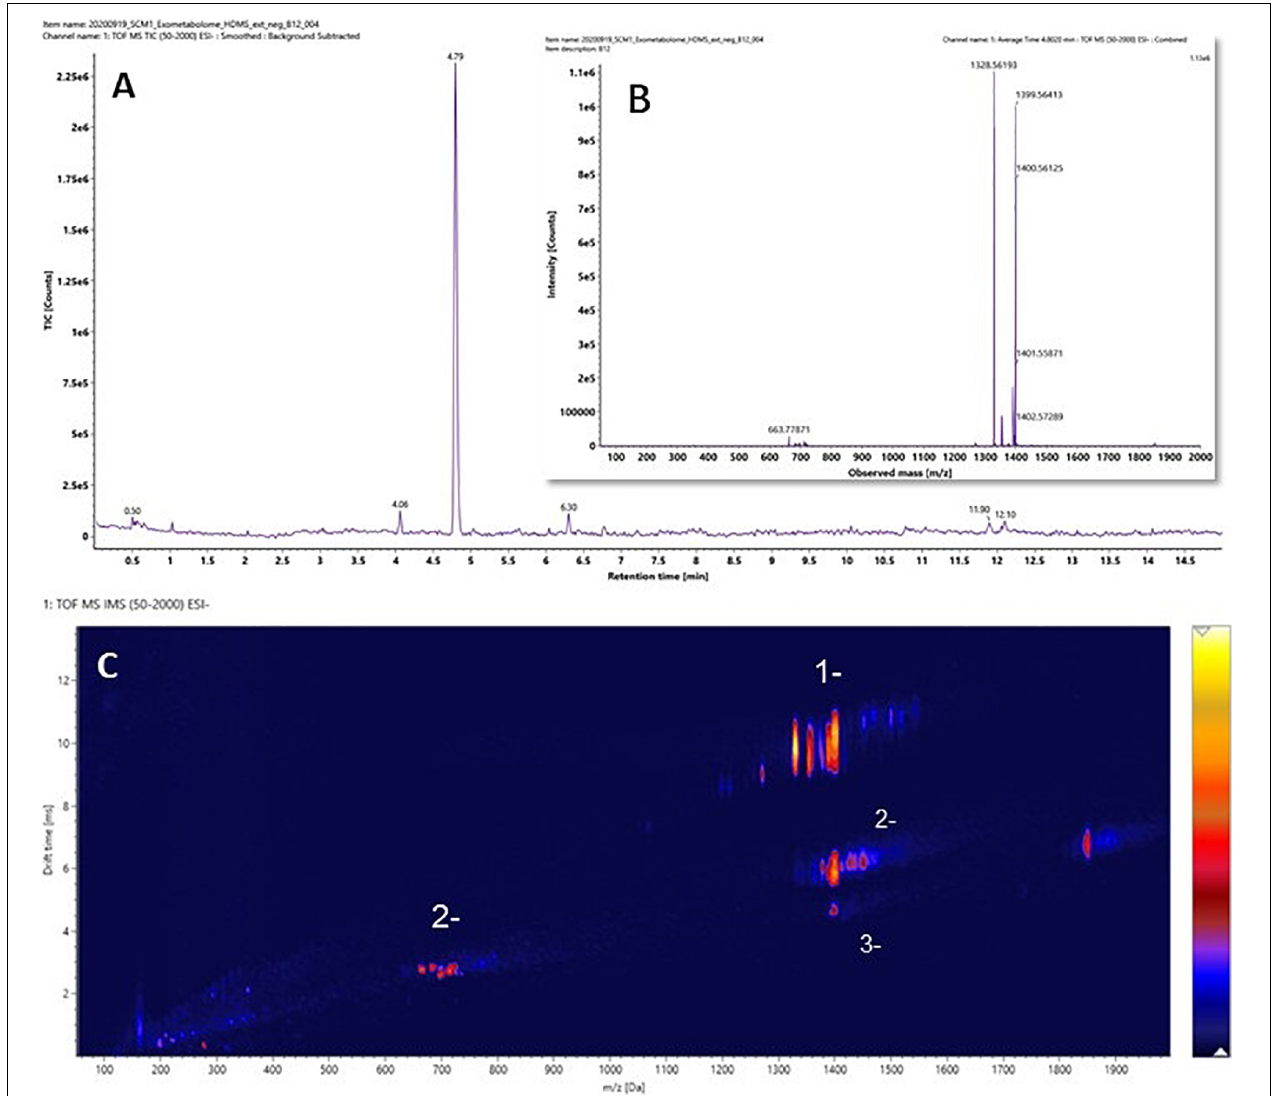
FIGURE 4 | (A) The ion chromatography, (B) the mass spectrum, and (C) the ion mobility characteristics of Vitamin B 12 (cobalamin). Data were acquired in the negative ion